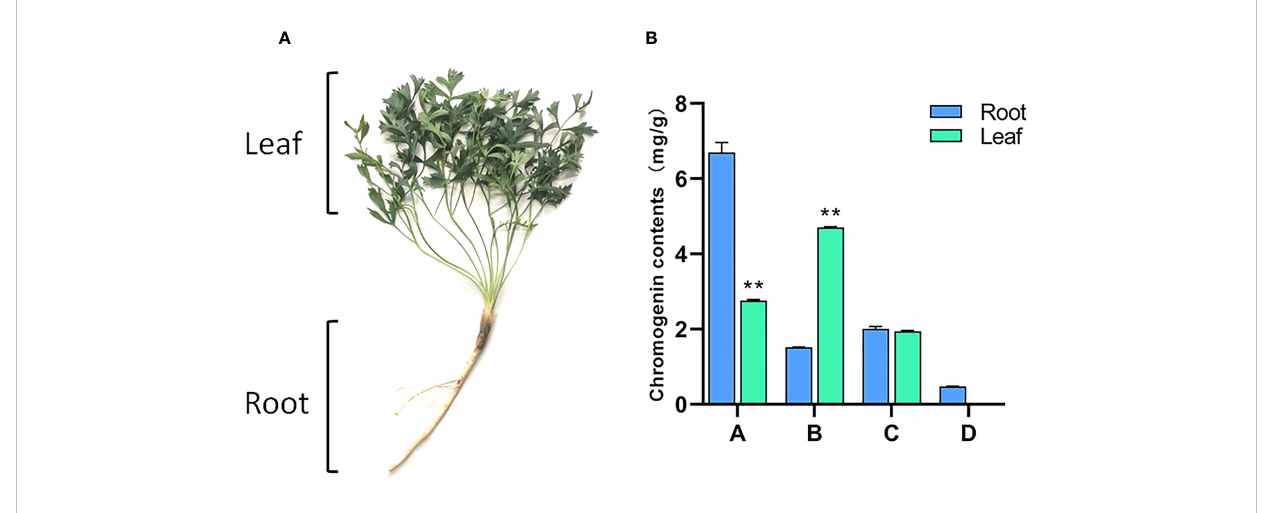
FIGURE 1 Root and leaf of S. divaricate . (A) Morphological difference of root and leaf of S. divaricate ; (B) Chromogenin contents in root and leaves. ( Note: A; prim- O -glucosylcimifugin; B; 4 ’ - O - b -D-glucosyl-5- O -methylvisamminol; C; cimifugin; D; sec- O -glucosylhamaudol. Compared with the root, **: Indicates extremely signi fi cant difference